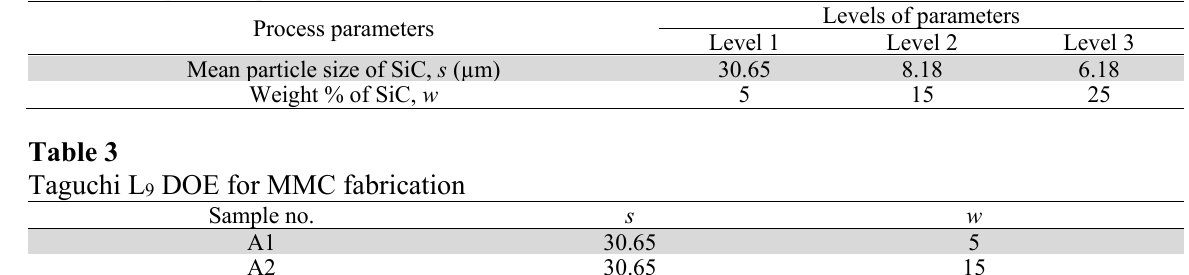
Fabrication process parameters and their levels Process parameters Mean particle size of SiC, s (µm)